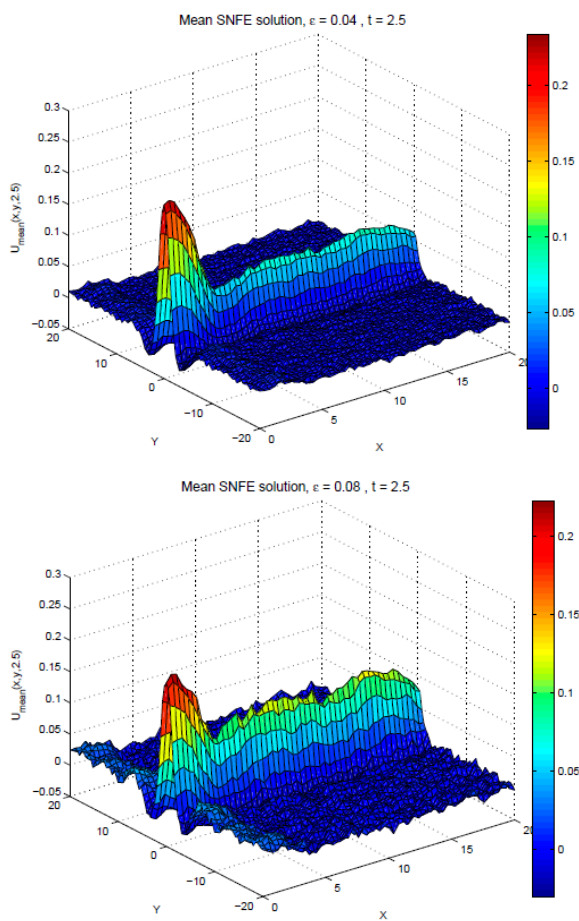
Figure 8. Snapshots of the solution of Example 1 at time t = 2.5: up- E = 0; down, left-hand side - E = 0.04; down, right- hand side - E =